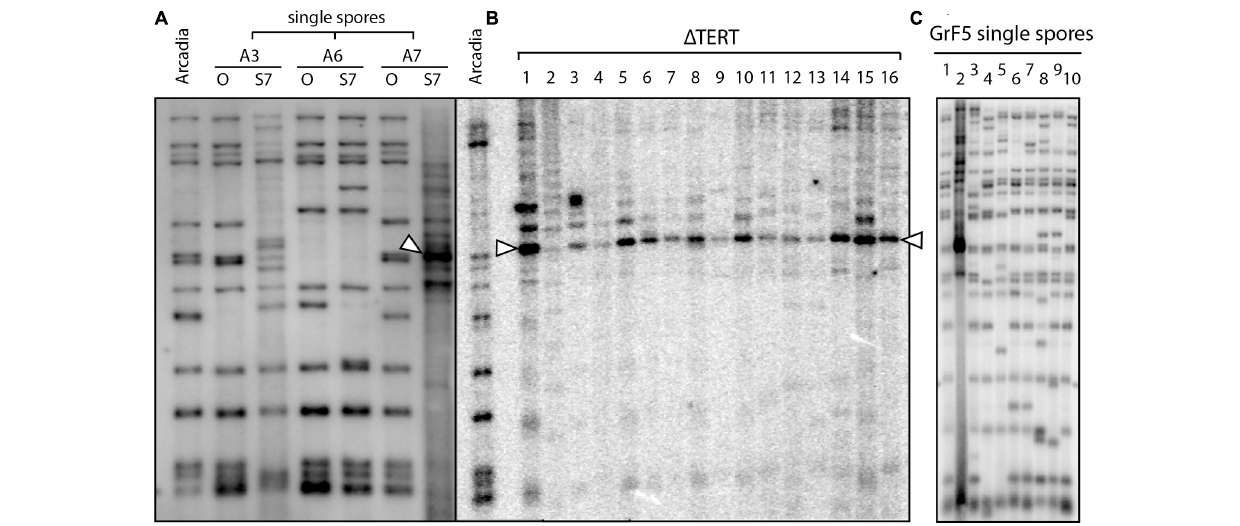
FIGURE 8 | Spontaneous telomere failure in foxtail pathogens. (A) Single spores (SSs) were isolated from transformants of strain Arcadia2 that had been transformed with a MoTeR1 expression construct (Lane A). Three of the SS cultures (A3, A6, A7) were serially transferred on agar medium for 7 generations. Genomic DNA was extracted from the original (O) and 7th generation subcultures (S7), digested with Pst I and analyzed by Southern hybridization with a telomere probe. Note that the telomere profiles for the S7 cultures of strains A3 and A7 are very different to the profiles of the originals. S7 shows a typical Type I alternative telomere maintenance pattern (arrowhead), consistent with tandem amplification of the vestigial telomere plus the telomere-adjacent region (including the Pst I site). Note the faint background signals in the A3-S7 lane. This culture appears to be in the early stages of ATF, with several novel telomeres appearing. By comparison, S7 appears to have a more advanced ATF. (B) shows Pst I telomere fingerprints for 16 TERT KO strains in the wild-type Arcadia2 background. If one compares the profiles of the left lane (Arcadia2, A) with the A7/O lane, it appears that the fragment amplified in A7/S7 is the same as ones amplified in several TERT KO strains (arrowheads). (C) Variation in telomere fingerprint profiles among 10 single-spore cultures that were all isolates from a single parent culture that was also recently single-spored. Note the single, intense signal in culture 2 that indicates recent operation of an alternative telomere maintenance